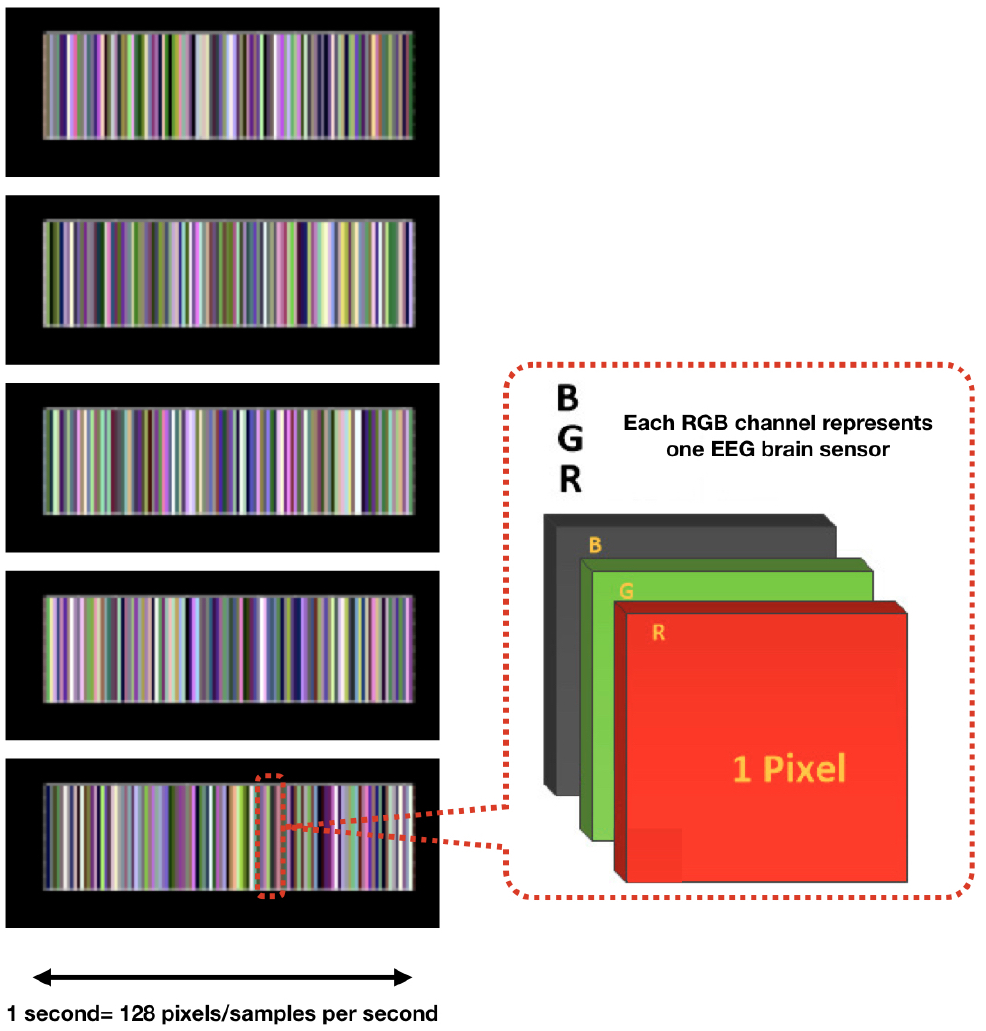
Figure 6. Multichannel Method